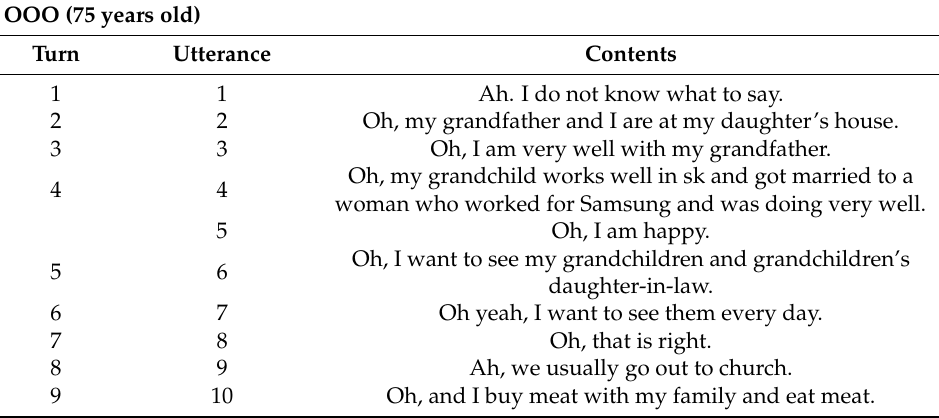
Table 3. Example of transcription